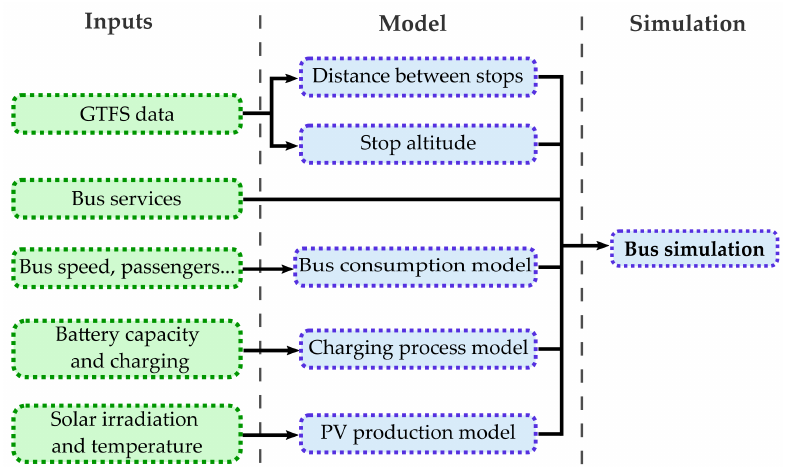
Figure 1. Flow chart of the modelling approach with the inputs and the computation